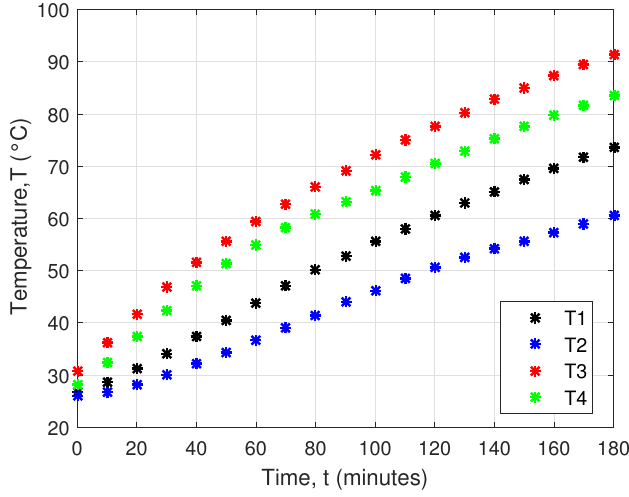
Figure 9. Measured soil